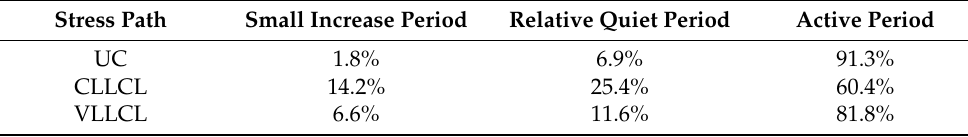
Figure 11. The AE energy evolution and location under VLLCL. ( a ) Sandstone; ( b ) granite. Table 1. The proportions of AE energy in AE period under different stress